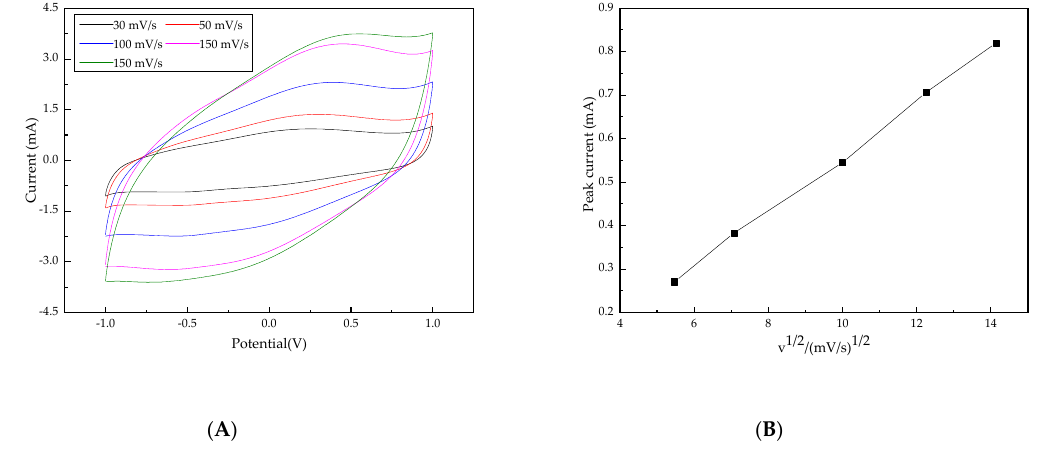
Figure 11. CV curves of the Ti/Ta 2 O 5 -IrO 2 electrode at different scan rates. ( A ) CV curves at different scan rates; ( B ) The plots of peak current vs. the square root of scan rate.